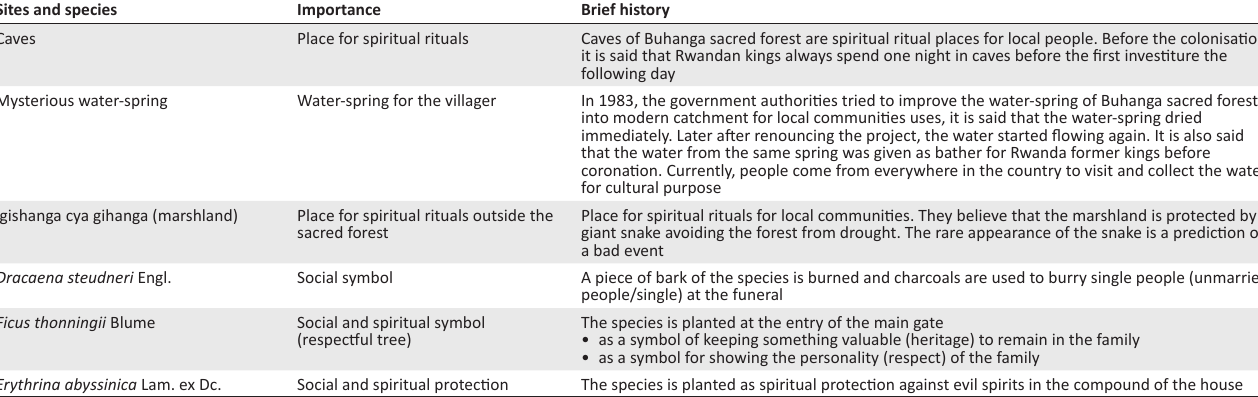
TABLE 2: Name of sites and species of spiritual importance among local people. Sites and